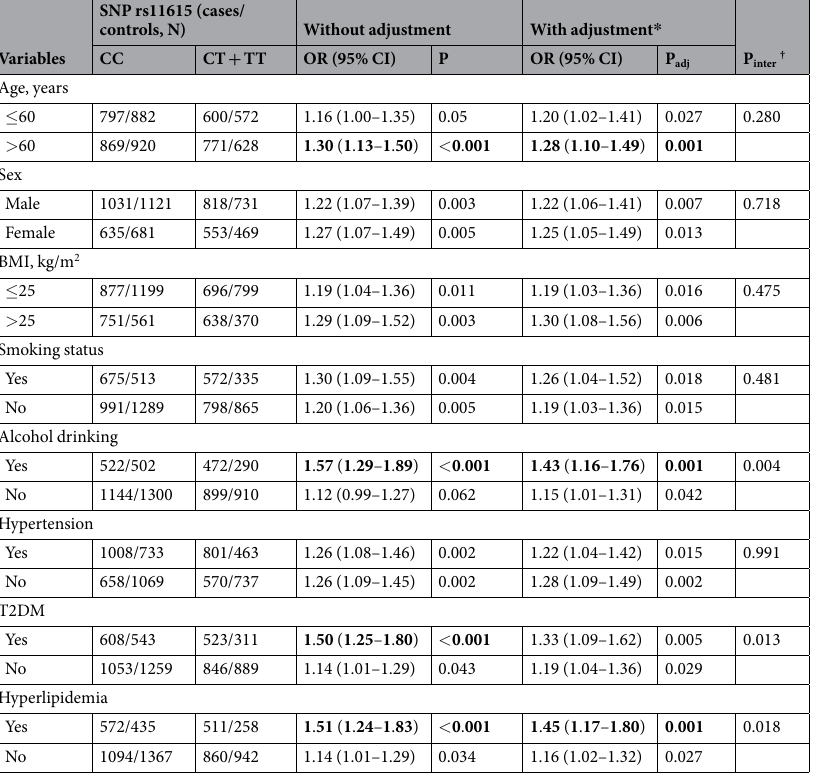
Table 3. Subgroup analyses for the association of SNP rs11615 with CAD risk. N, number; OR (95CI), odds ratio (95% confidence interval); SNP, single nucleotide polymorphism; BMI, body mass index; T2DM, type 2 diabetes mellitus. * Adjusted OR (95% CI) and P adj values were obtained from logistic regression analyses after adjusting for age, sex, BMI, smoking status, alcohol drinking and histories of T2DM, hyperlipidemia and hypertension. † P inter values were obtained from the multiplicative likelihood ratio test to assess the interactions between SNP rs11615 and selected variables in CAD risk. Bold values indicate statistically significant after the Bonferroni correction (P < 0.05/40 =